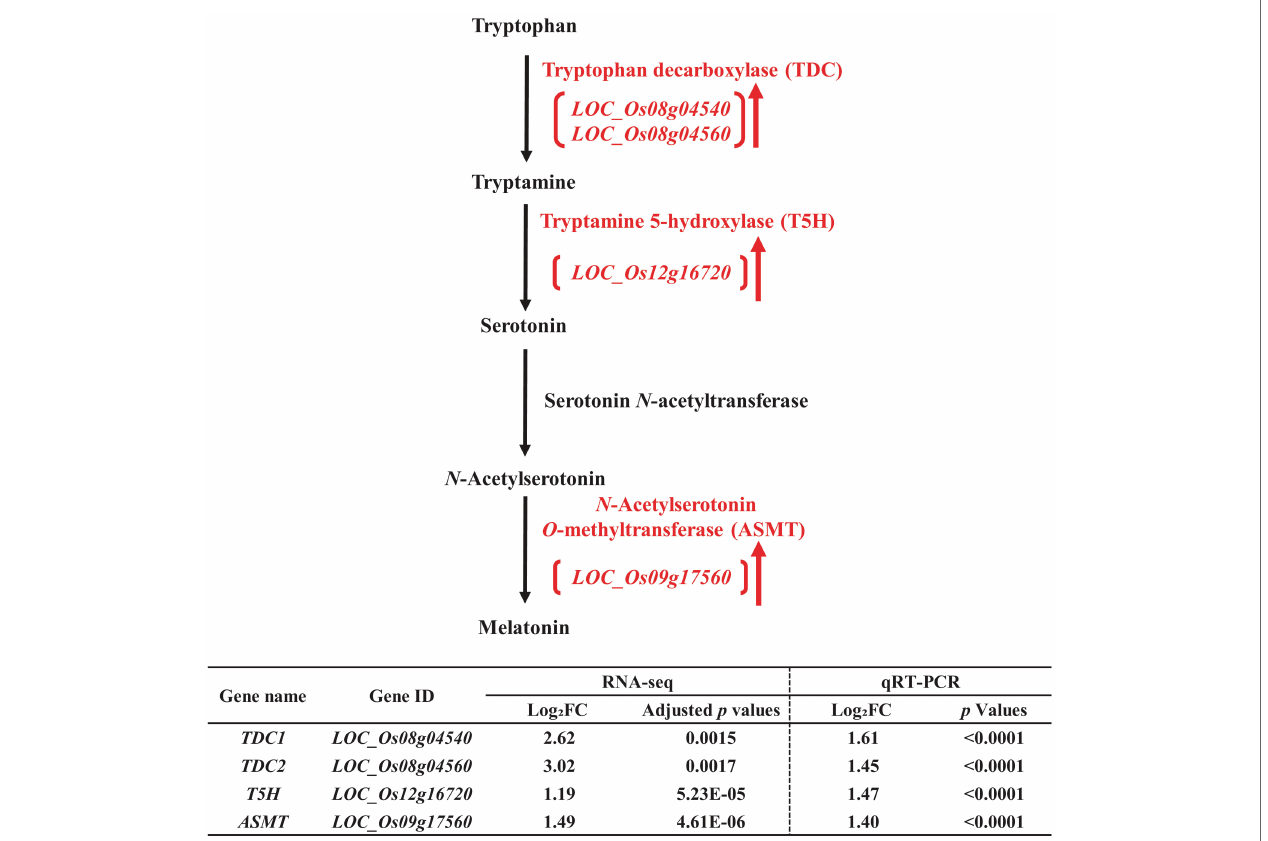
FIGURE 4 | Biosynthetic pathway of melatonin in the developing seeds of Samgwang grown on reclaimed land (RL) and verification of upregulated genes through qRT- PCR. ↑ indicates upregulation. The Log 2 FC (FC, fold change) expresses the Log 2 value of a ratio of expression value of RL to that of normal land (NL; RL/NL), which was generated by RNA-seq and qRT-PCR, respectively, from the developing seeds of Samgwang. The significant difference for each dataset was determined by t